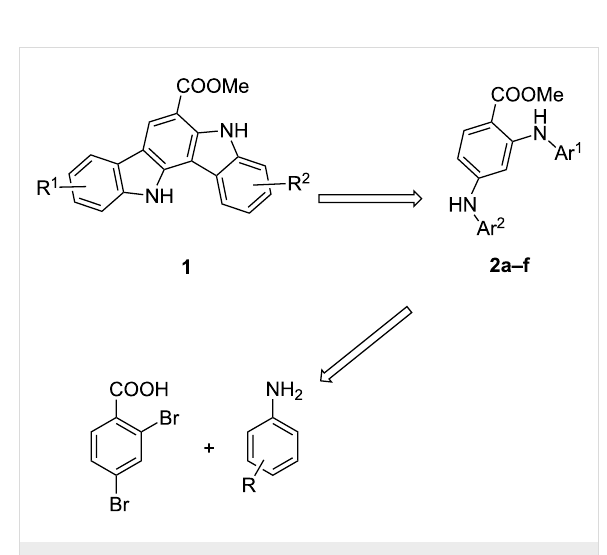
Figure 1: Natural indolo[3,2- a ]carbazole alkaloids.